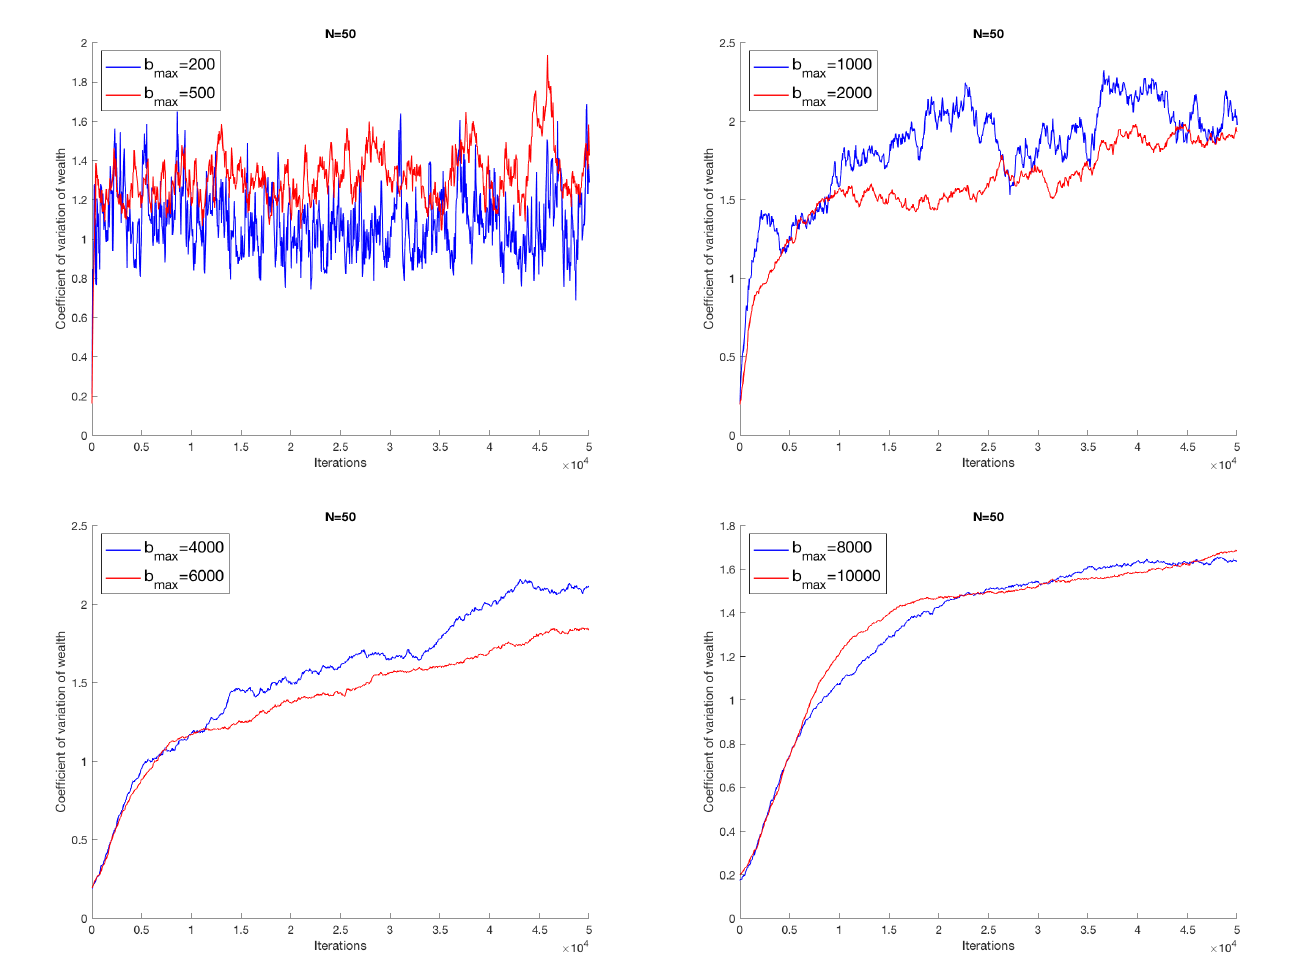
Figure 1. Plot of the coefficient of variation of the amount of money of the economic agents as transactions go on for N = 50 and b max = 200,500 ( top left ), b max = 1000,2000 ( top right ), b max = 4000,6000 ( bottom left ), b max = 8000, 10,000 ( bottom right